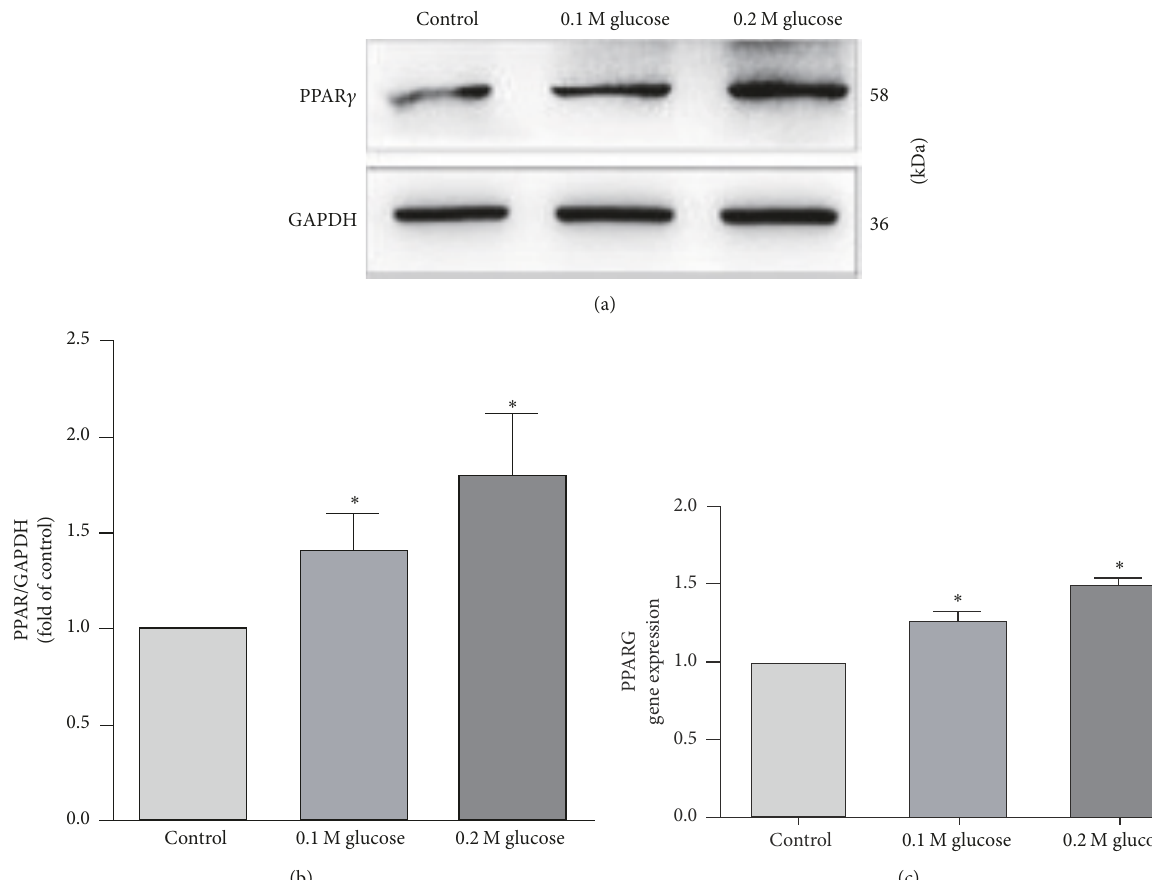
Figure 3: Real-Time PCR and western blot showed that PPAR 𝛾 expressed in the NP cells and the expression of PPAR 𝛾 increased when NP cells were treated with high glucose. ∗ represents a significant difference from the control group (𝑝 < .05)